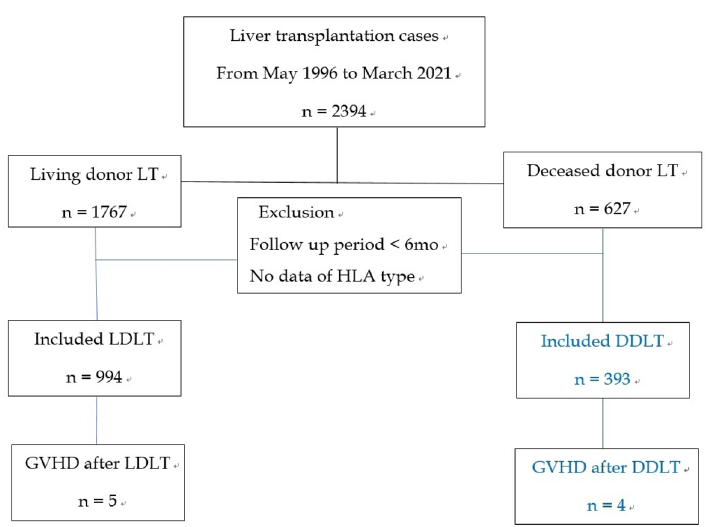
Figure 1. Flowchart of patient